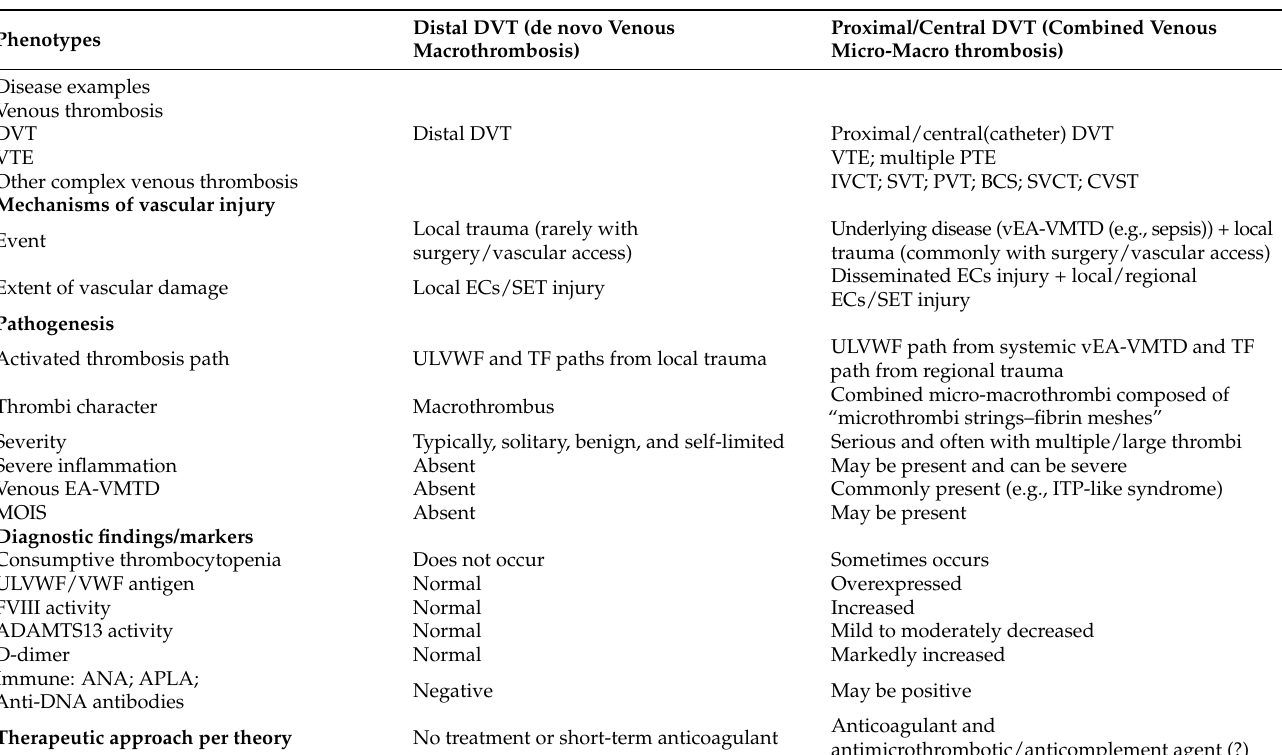
Table 2. Two faces of deep venous thrombosis with pathologic, pathogenetic and laboratory differences based on two-path unifying theory of hemostasis and endothelial molecular